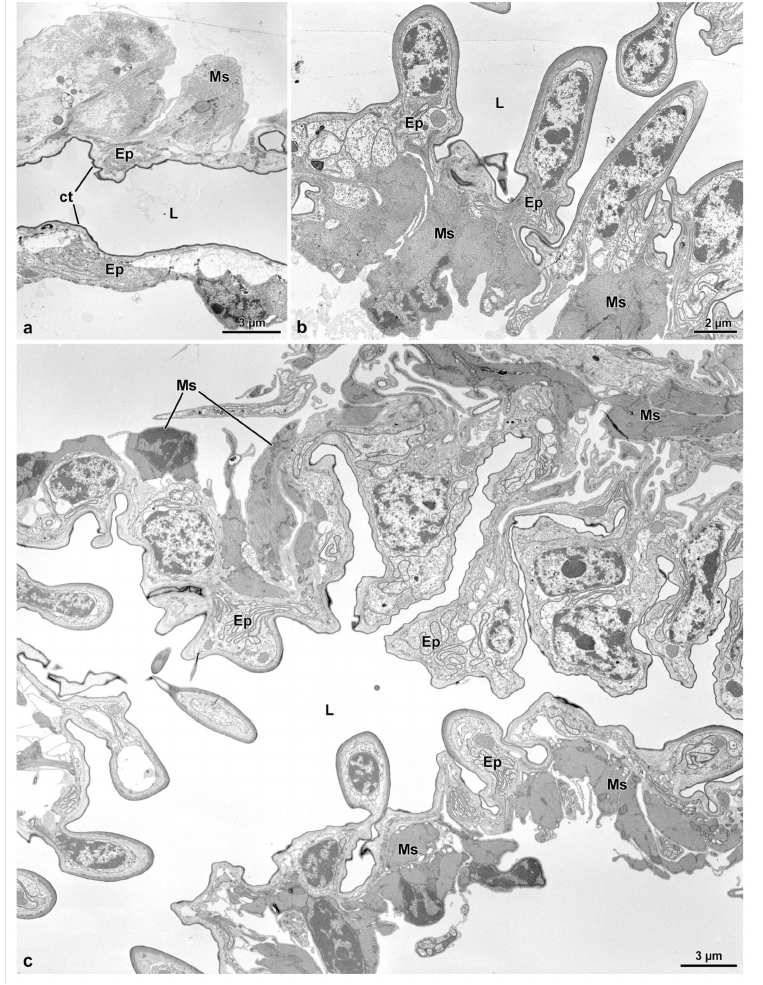
Figure 7. ( a ). Cross section of the fertilization duct showing a cuticular (ct) thin epithelium (Ep) with scattered muscle (Ms). L, duct lumen. ( b , c ). Cross sections through the characteristic epithelium (Ep) of the common oviduct, with epithelial cells often protruding into the lumen (L). Ms, Muscle